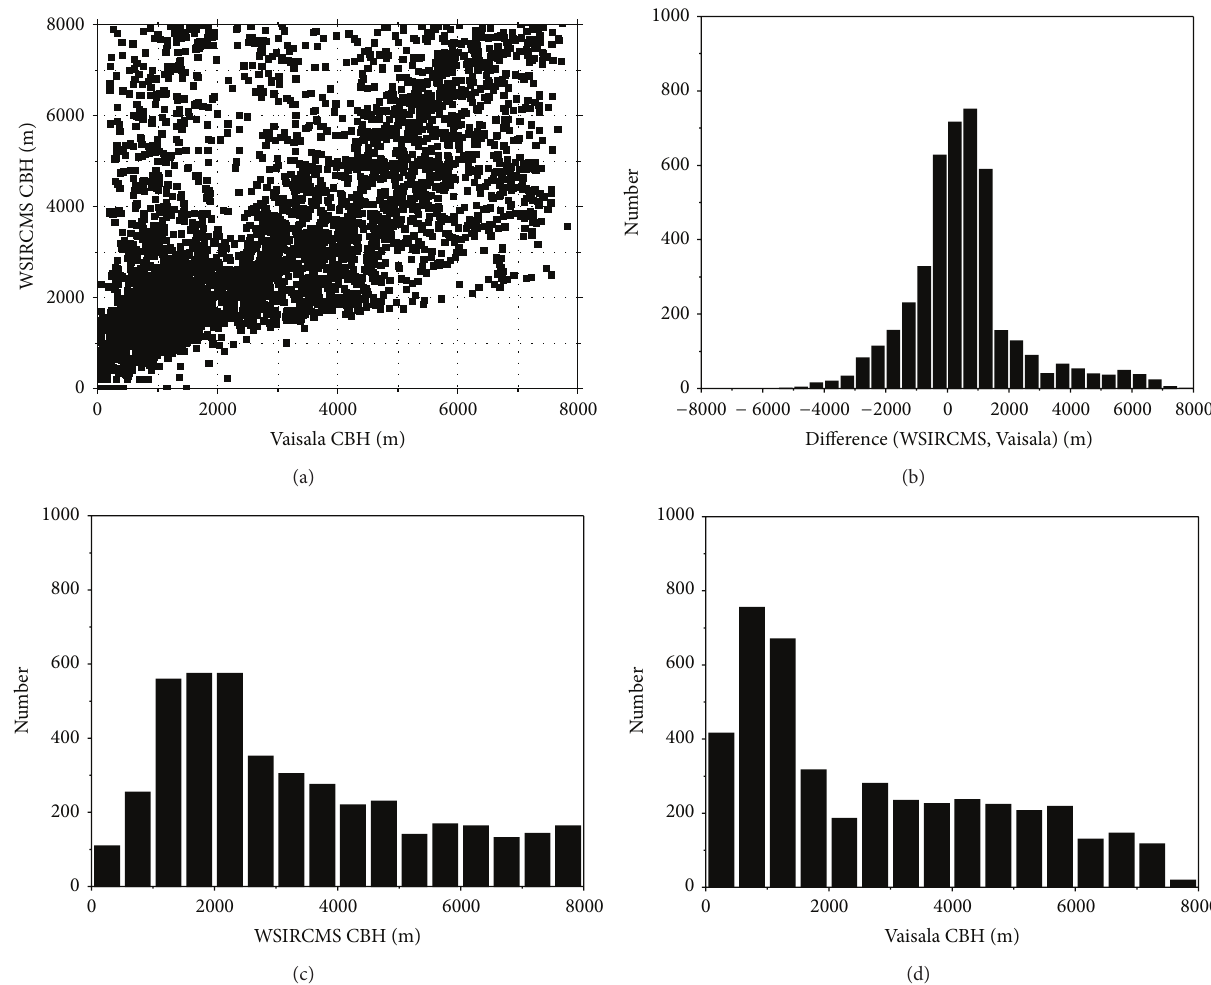
Figure 6: Cloud base height differences between WSIRCMS and ceilometer CL51 during the period November 1, 2011, to June 12, 2012, at the CMA Beijing Observatory Station.